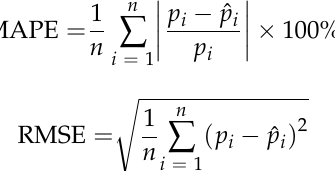
Figure 5. Load forecasting results based on different models: ( a ) 12 May; ( b ) 13 May; ( c ) 14 May; ( d ) 15 May.